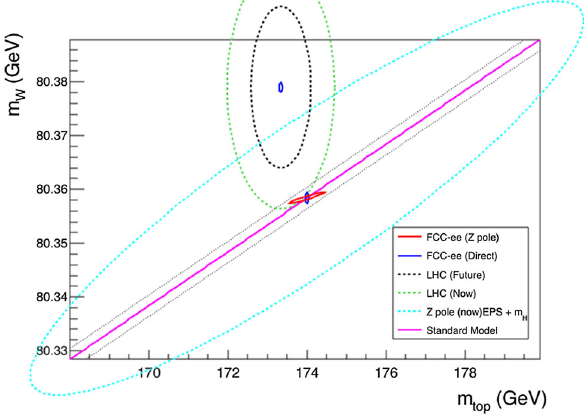
Fig. 8.1 Contours of 68% confidence level in the ( m top , m W ) plane obtained from fits of the SM to the EW precision measurements offered by the FCC-ee, under the assumption that all relevant theory uncertainties can be reduced to match the experimental uncertainties: the red ellipse is obtained from the FCC-ee measurements at the Z pole, while the blue ellipses arise from the FCC-ee direct measurements of the W and top masses. The two dotted lines around the SM prediction illustrate the uncertainty from the Z mass measurement if it were not improved at the FCC-ee. The green ellipse corresponds to the current W and top mass uncertainties from the Tevatron and the LHC. The potential future improvements from the LHC are illustrated by the black dashed